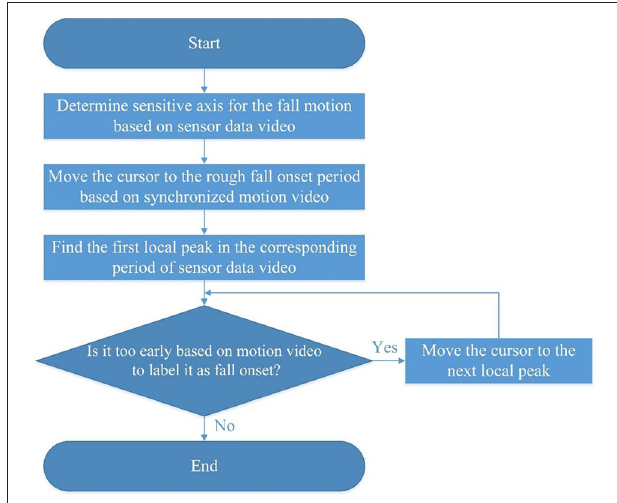
FIGURE 3 | A flowchart for labeling the fall onset moment in sensor